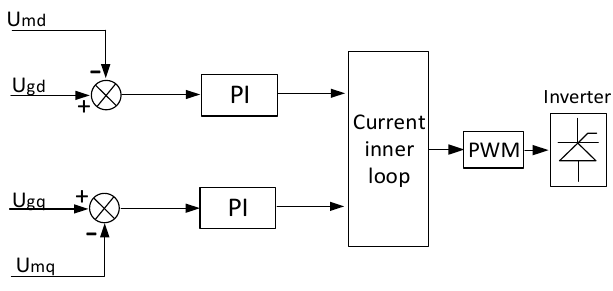
Figure 9. Scheme of pre-synchronization